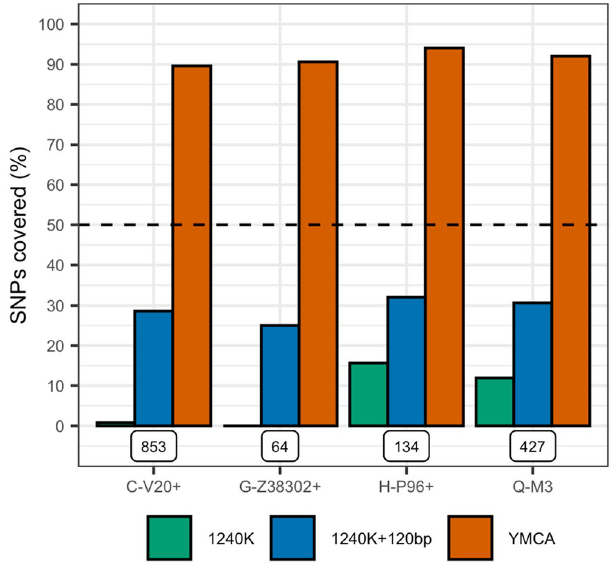
Figure 2. The percentage of SNPs (y-axis) covered (up to three branches downstream) for four Y-chromosome haplogroups (x-axis) associated with ancient populations. Colours indicate assay SNPs targeted for 1240 k (green), 1240 k with a 120 bp window (blue) and our YMCA (orange). The dashed black line indicates at least half of the SNPs are represented, and the total number of targetable SNPs is given below each